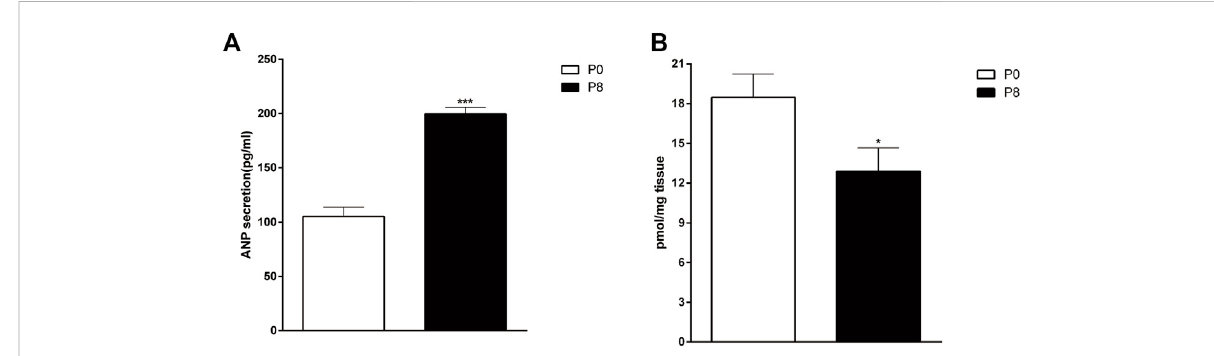
FIGURE 4 Effects of rapid pacing on atrial ANPsecretion and cGMP concentrations in rabbits. (A) Changes in ANP secretion (A) and cGMP concentrations (B) after 8 h of rapid pacing stimulation. *** p < 0.001 vs. P0. Data are expressed as means ± SEMs. n = 6.